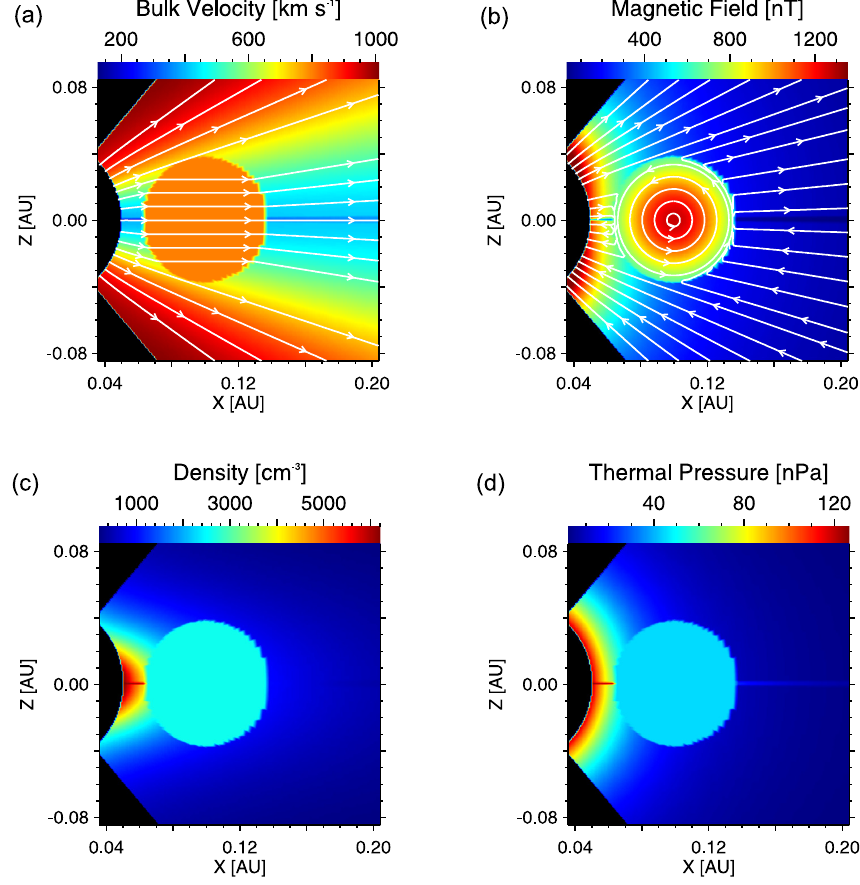
Fig. 1. Distributions of plasma speed (a) , magnetic field (b) , number density (c) and thermal pressure (d) for the initial state of the background solar wind and for the initial circular magnetic cloud cross section. Distributions are shown in a meridional plane near the inner boundary of the grid. Streamlines for velocity and field lines for the magnetic field are over-plotted as a projection onto the plane of